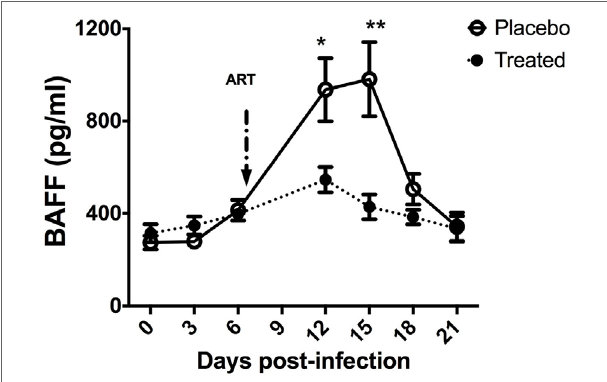
FiGURe 2 | B-cell-activating factor (BAFF) levels in SIV-infected macaques upon antiretroviral therapy. Two groups of five macaques infected for 7 days by SIVmac 251 (50AID50) were treated or not (placebo) with antiretroviral therapy for 2 weeks and euthanized at day 21 post-infection (pi). Plasma BAFF concentration was determined using the BAFF Quantikine ELISA kit (R&D systems) in samples collected before infection and every 3 days pi. At each time point, mean value ± SEM is indicated for each group. At each time point, significant differences between treated and placebo groups were calculated by a Wilcoxon sign-ranked test (two-tailed, unpaired, and non-parametric t -test). The p values *( p < 0.05) and **( p < 0.01) were considered as